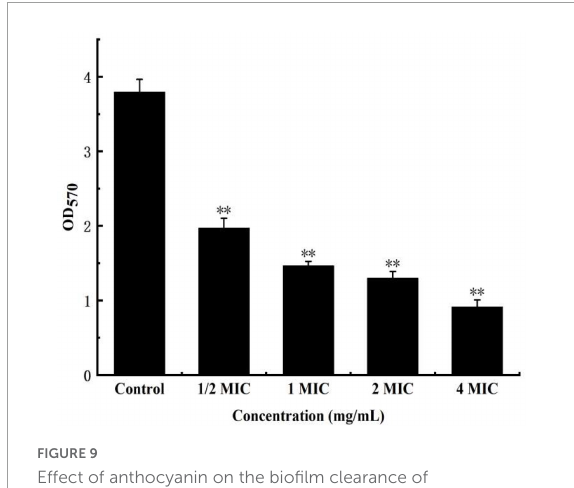
FIGURE9 Effect of anthocyanin on the biofilm clearance of Staphylococcus aureus by semi-quantitative (modified crystal violet staining method) method. ∗∗ P < 0.01.